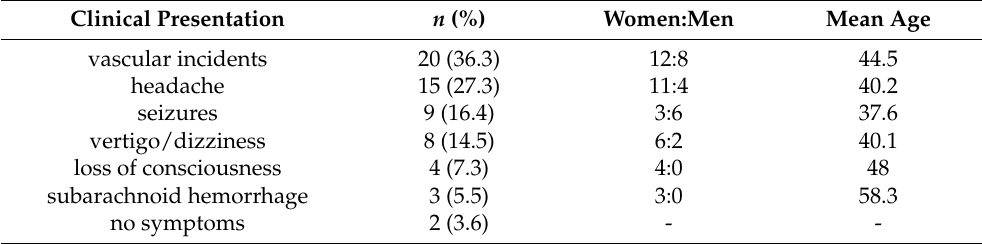
Table 2. The most common clinical symptoms.